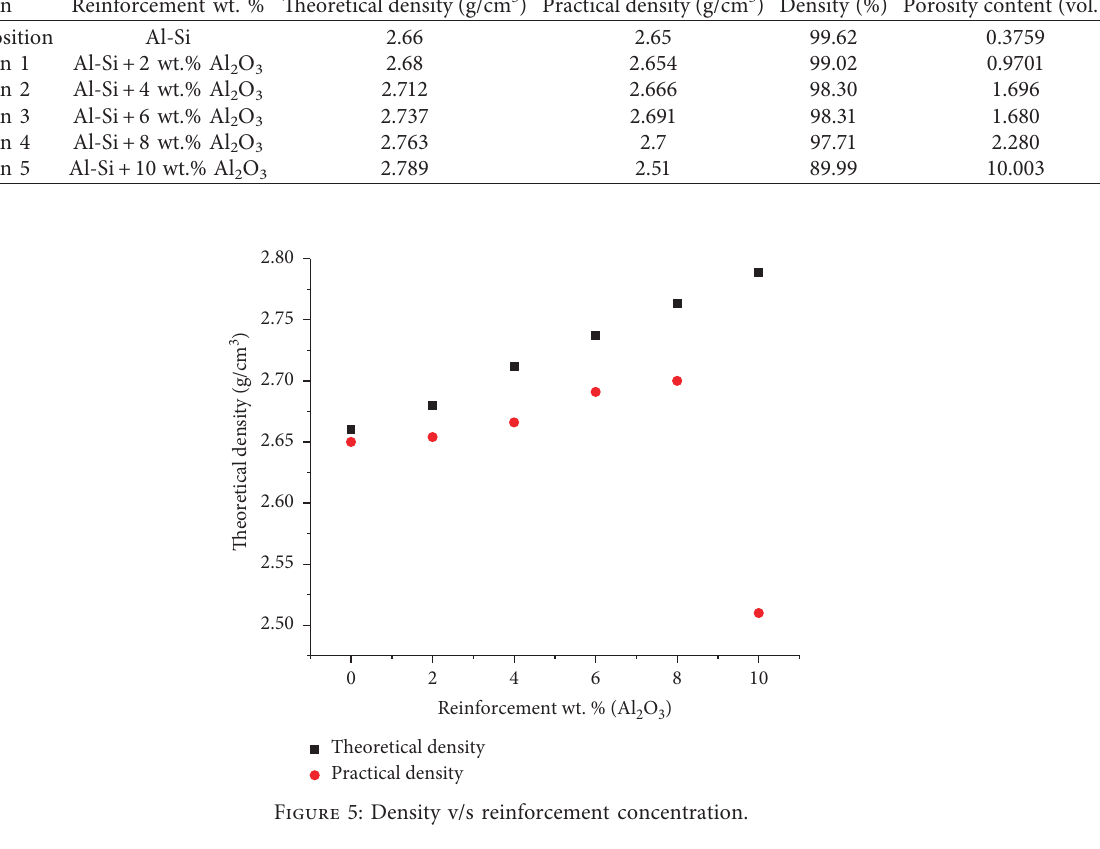
Table 1: Theoretical density, practical density, and porosity content comparison for different composition samples. Composition